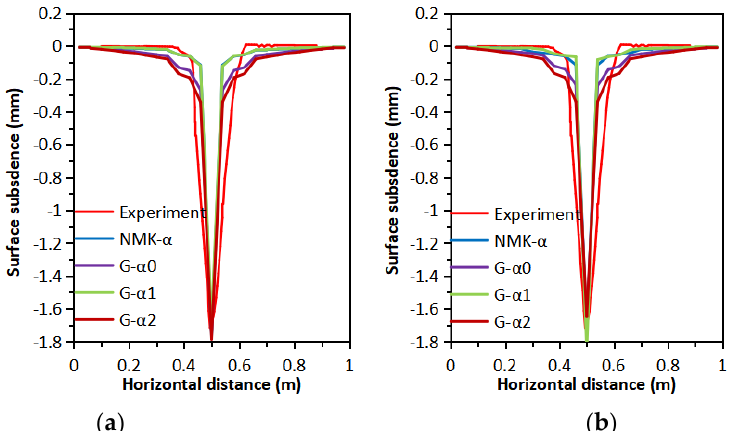
Figure 23. Surface subsidence simulated by the referred schemes: ( a ) ∆𝑡 = 0.1 ms; ( b ) ∆𝑡 = 0.01 ms.